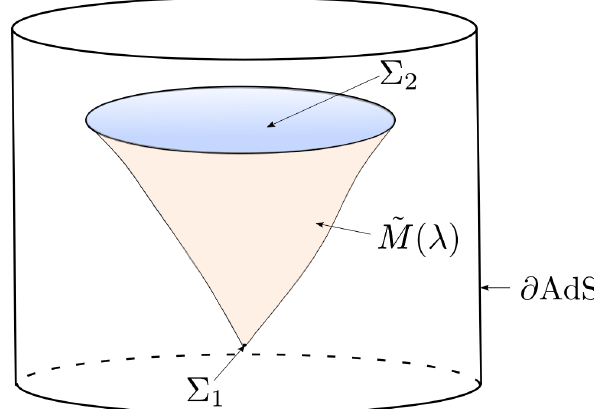
Figure 2: A fine-grained description of the preparation of a bulk state from ‘nothing’. The initial state lives on a surface Σ embedded deep in the IR of an asymptotically 1 AdS spacetime. This corresponds to a state in a T T -deformed CFT with very large deformation parameter. We take this to be the reference state when defining the state complexity of the final state on Σ 2